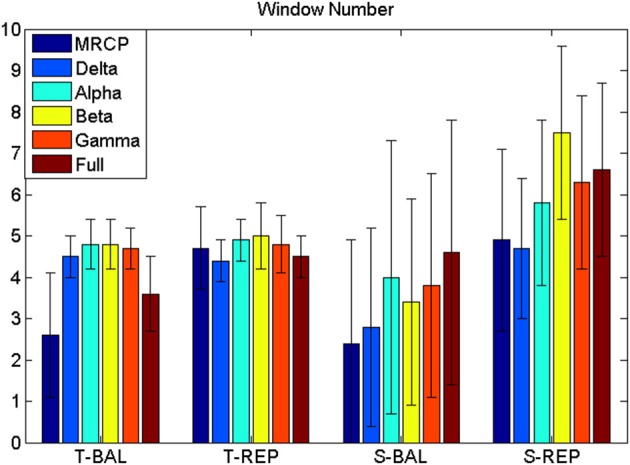
Window number (WN). WN is chosen where false positive ≤ 8 min−1. T-BAL and T-REP represent ballistic and repetitive task with time serial analysis, while S-BAL and S-REP stand for these two motor task with subband power estimation.